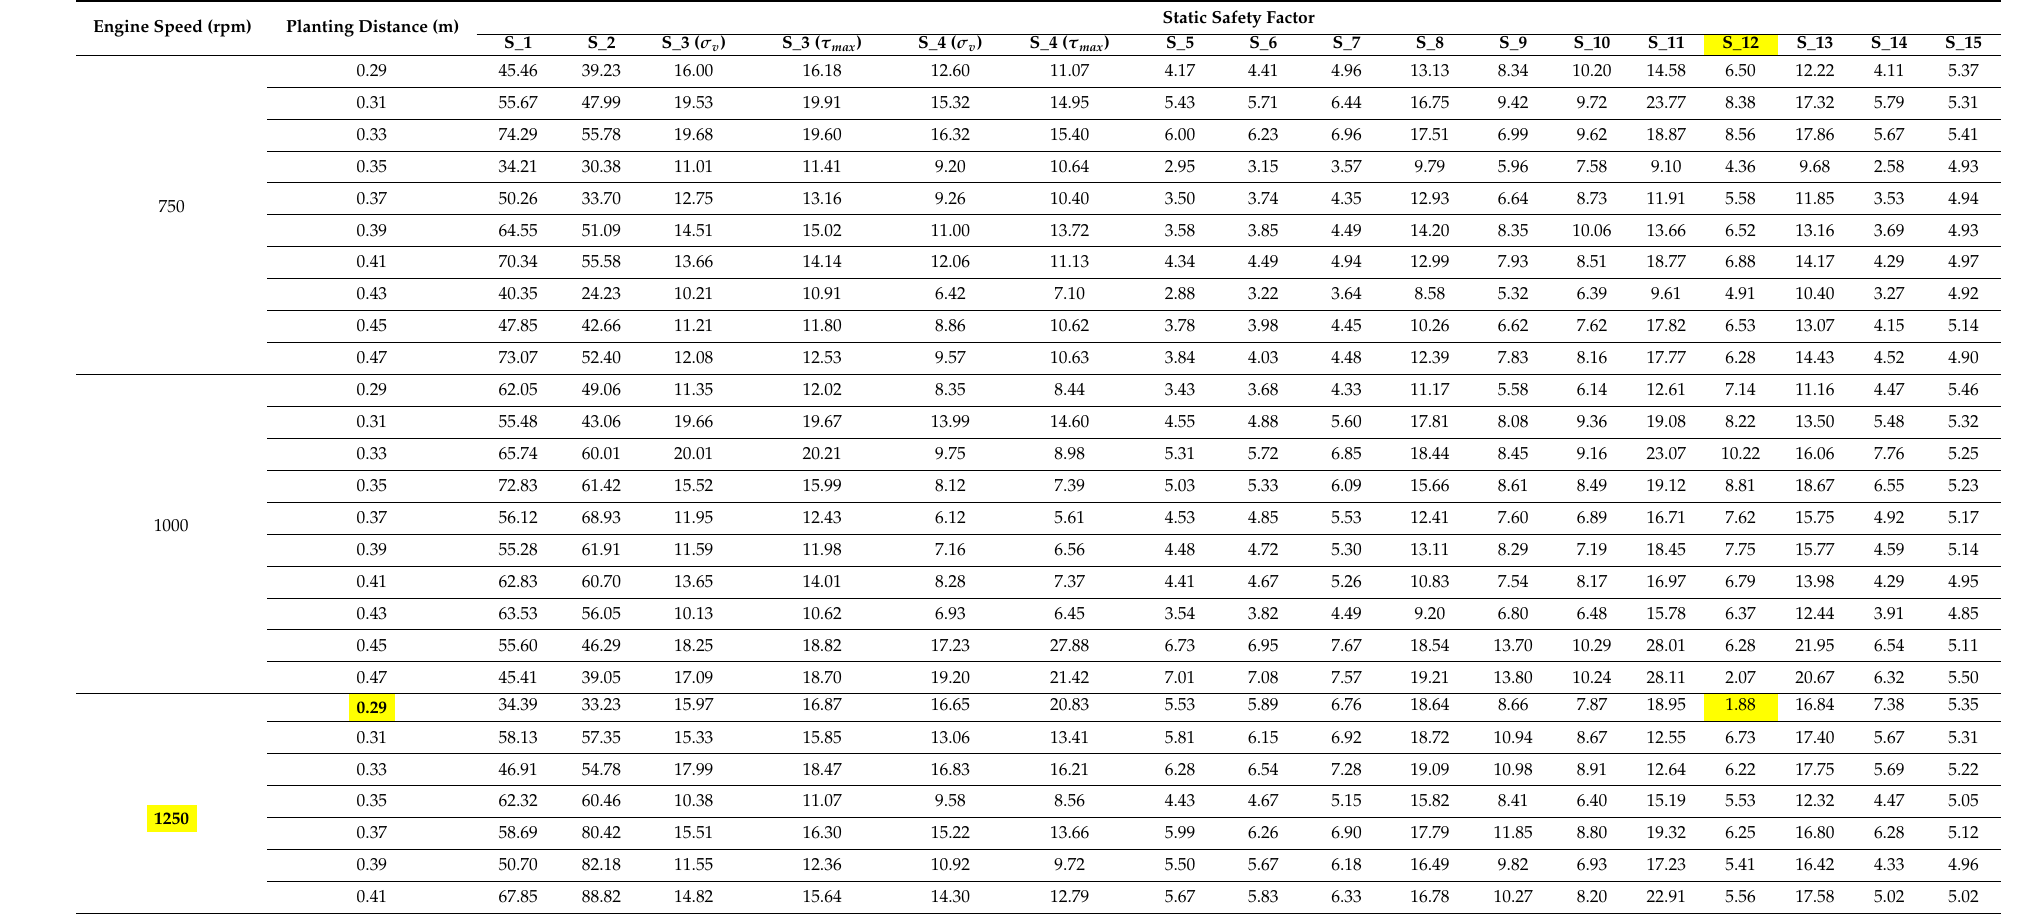
Table 1. Static safety factor in every spot of strain gauge under each working